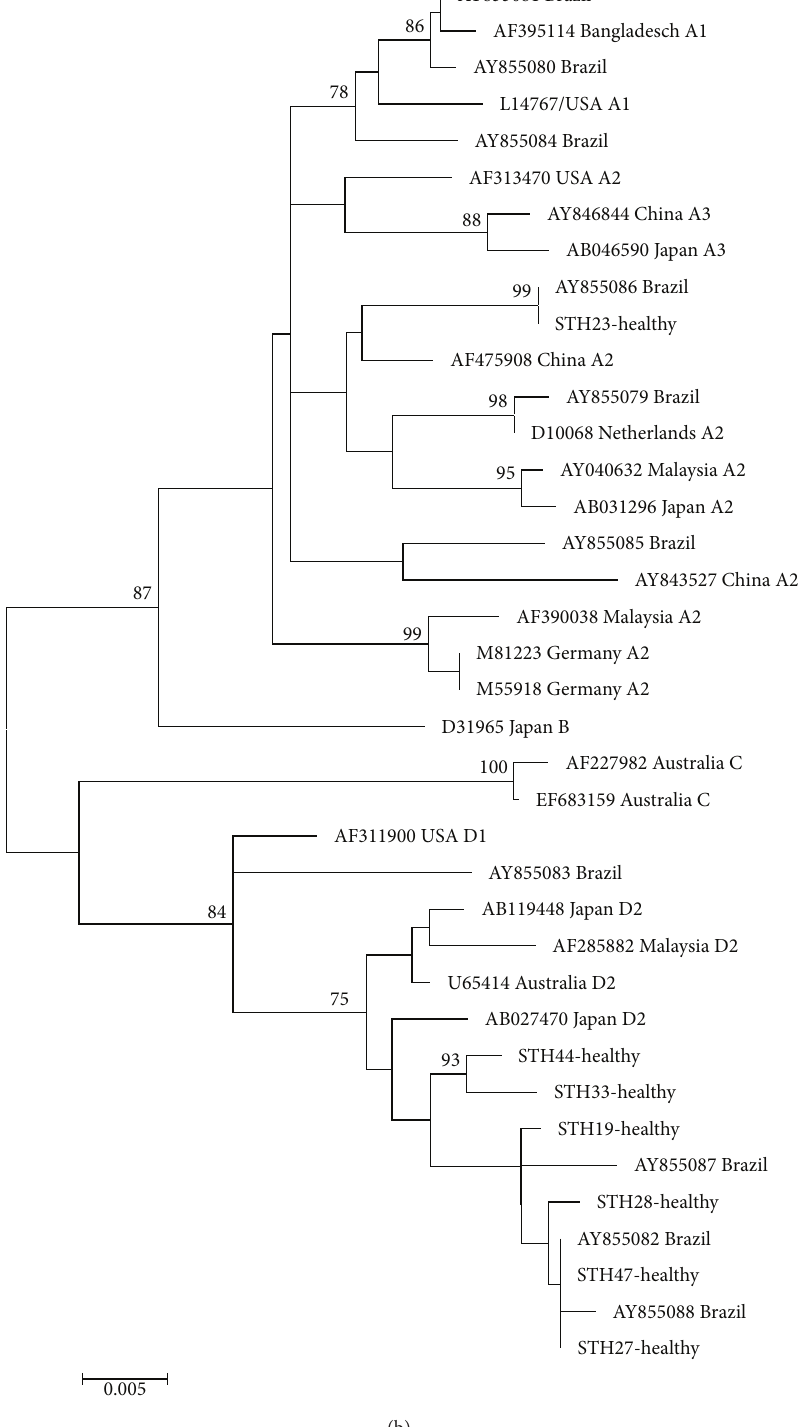
Figure 1: Phylogenetic trees generated by neighbour-joining analysis of the VP2 region of AGV2, HGyV1, and GyV3 (a) and CAV VP1 (b) of South African isolates of human and chicken origin. Reference sequences of AGV2, HGyV1, GyV3, and CAV were retrieved from the NCBI GenBank database and are indicated by accession numbers and country of origin. Bootstrap values greater than 75% are indicated at the nodes of the tree. The branch lengths are proportional to the evolutionary distances as shown on the